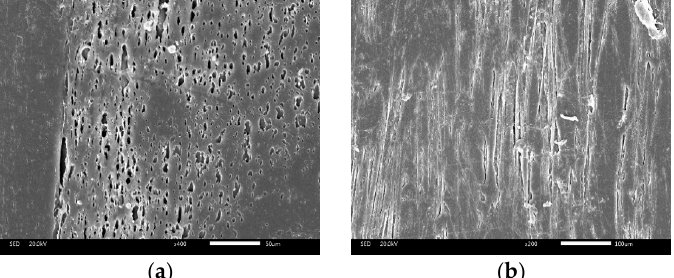
Figure 15. Different types of cells on the surface: ( a ) cells spilled from melt surface; ( b ) broken cells from melt flow front.